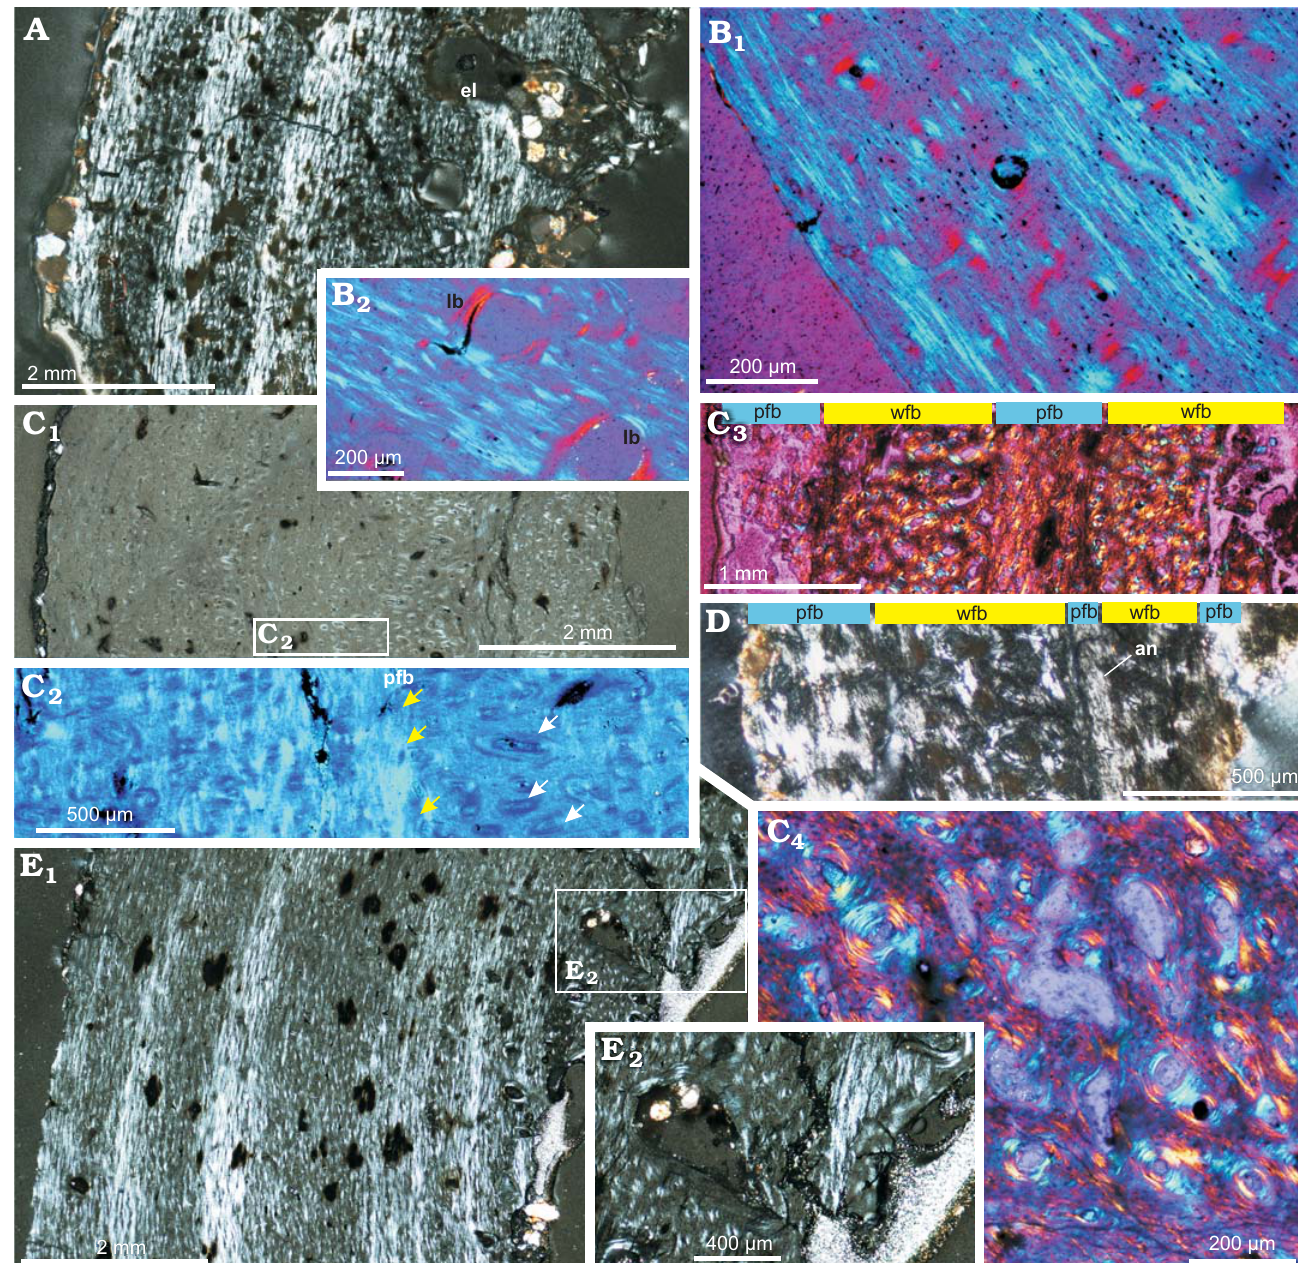
Fig. 8. Bone microstructure of subadult Protoceratops andrewsi Granger and Gregory, 1923, Toogreek (A, C, E) and Bayn Dzak (B, D), Mongolia, Late Cretaceous. A . Humerus ZPAL MgD-II/35a, total view of the compacta displaying patches of parallel-fibered bone (light bands) intercalated by zones of woven-fibered bone with multiple primary osteons (dark bands); note erosion lacunae in the inner cortex. B . Humerus ZPAL MgD-II/15, external cortex showing primary osteons and plies of the parallel fibered bone matrix (B 1 ), perimedullar region showing lamellar bone lining erosion lacunae in primary woven-fibered bone tissue (B 2 ). C , D . Compacta of femora. C . ZPAL MgD-II/35b, section showing modulations in canal arrangement and bone matrix; C 1 , general picture of the whole bone wall; C 2 , magnification illustrating thick band (yellow arrows) of the parallel-fibered bone and longitudinal canals changing orientation to radial (white arrows); C 3 , section placed closer to the epiphysis, showing stronger zonation in bone matrix type; C 4 , deep cortex showing enlarged canals in a woven-fibered bone. D . ZPAL MgD-II/3d, cortex showing ill defined annulus and less clear modulations of the bone matrix. E . Tibia ZPAL MgD-II/35c, whole compacta (E 1 ) and deep cortex (E 2 ). The section displays a typical fibrolamellar bone complex with zonation in the bone matrix. The outer cortex displays zones of parallel-fibered bone matrix intercalated with the zones of more chaotically oriented collagen fibers, the perimedullar region shows larger erosion lacunae filled with endosteally formed lamellar bone (E 2 ). A, C 1 , D, E, polarized light; B, C 2 –C 4 , polarized light (quartz wedge). Abbreviations: an, annulus; el, erosion lacunae; lb, lamellar bone; pfb, parallel-fibered bone; wfb, woven-fibered